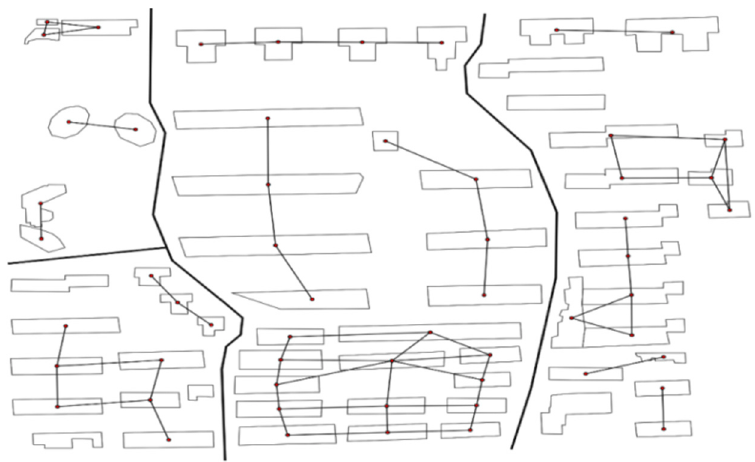
Figure 9. Proximity graph that is segmented by the types of textures.